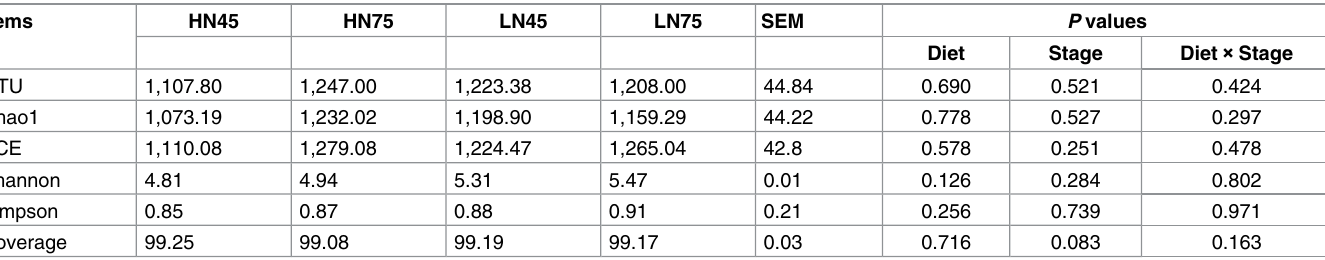
Table 2. Alpha diversity indices of ileal bacterial communities in Huanjiang mini-pigs at different stages of pregnancy a . Items HN45 HN75 LN45 LN75 SEM P